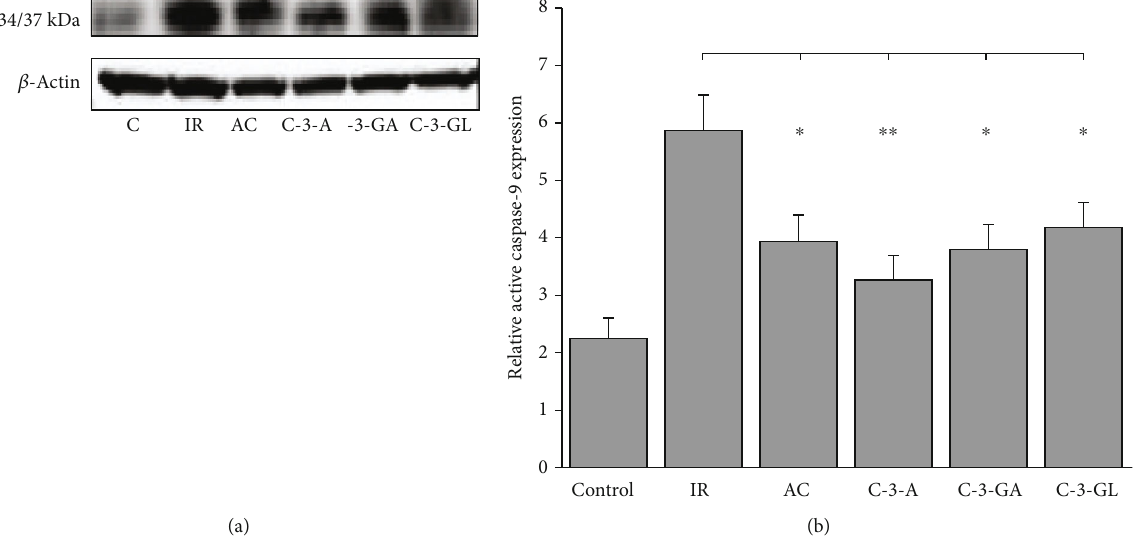
Figure 9: Caspase-9 expression in the kidney of the renal IR injury and anthocyanin treatment. (a) Representative Western blot of intrarenal activated cleaved caspase-9. (b) Densitometric analysis of caspase-9 expression (the means ± SD , n = 13 per group). IR: ischemia/reperfusion; AC: anthocyanins; C-3-A: cyanidin-3-arabinoside; C-3-G: cyanidin-3-glucodise; C-3-GA: cyanidin-3-galactoside. The comparison between treated mice and IR was indicated by asterisks. # P < 0 : 01 vs. control; ∗ P < 0 : 05 and ∗∗ P < 0 : 01 vs.